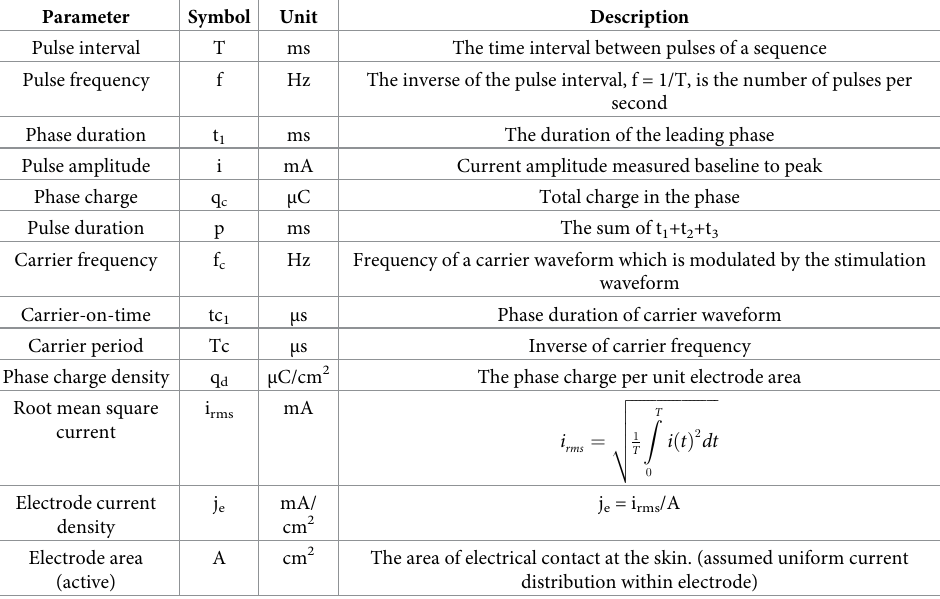
Table 2. Summary of stimulation parameters and a detailed description of how they are defined. Definitions and characteristics of stimulation